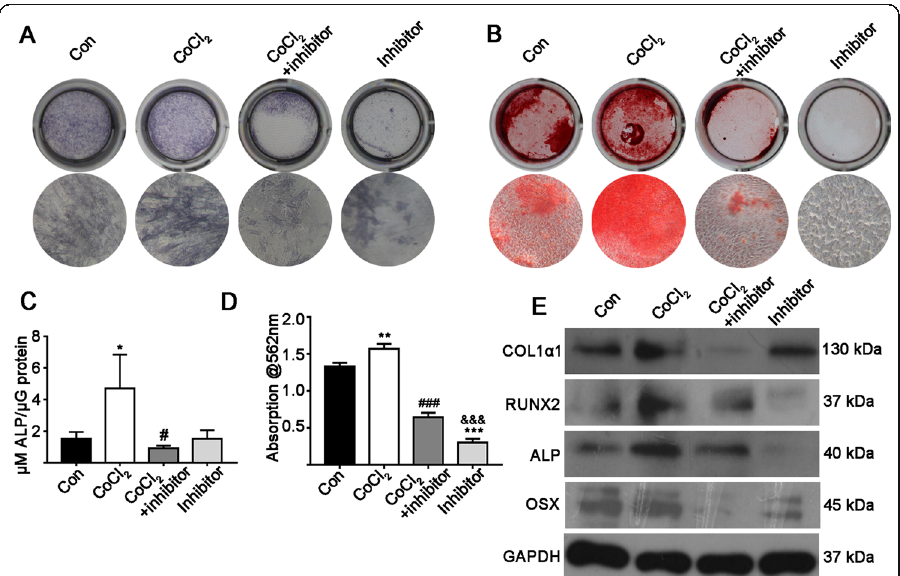
Fig. 4 The effect of continuous hypoxia for 3 days on days 1, 3, 5 and 7 of culture with or without a STAT3 inhibitor. a ALP staining on day 7. b Matrix mineralization (alizarin red staining) on day 14. c ALP activity on day 7. d Quantitative analysis of alizarin red staining. e Osteogenic differentiation marker (protein) expression. Data of quantitative analysis are the means ± SD from 5 independent experiments, n = 5. Significant effect of the treatment compared to the control group: * p < 0.05, ** p < 0.01 and *** p < 0.001; the CoCl 2 group: # p < 0.01, ### p < 0.001; and the CoCl 2 + inhibitor group: &&& p < 0.001. Inhibitor: STAT3